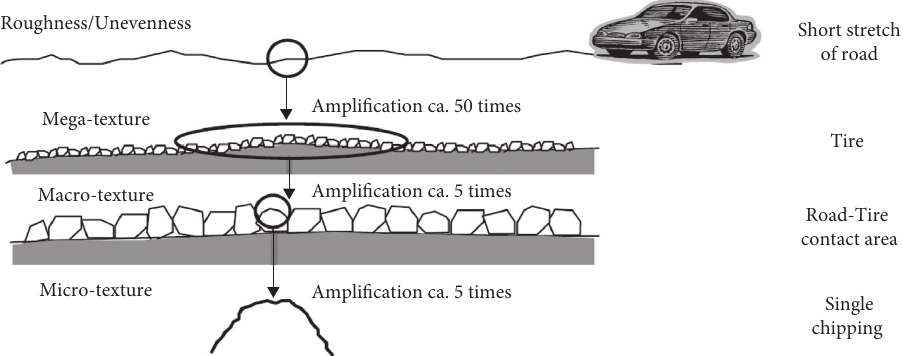
Figure 3: Illustration of the various texture ranges that exist for a given pavement surface